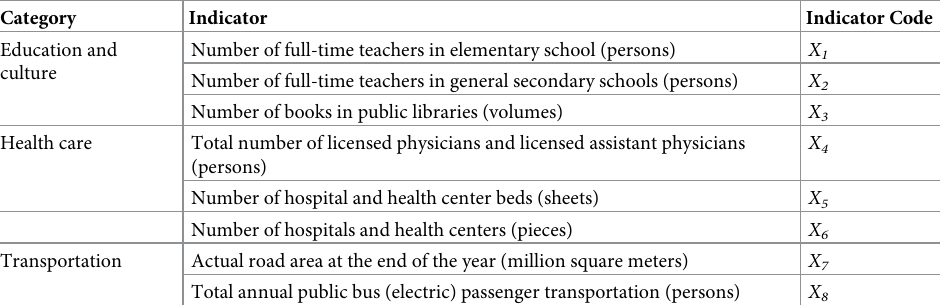
Table 1. Quality of public services evaluation